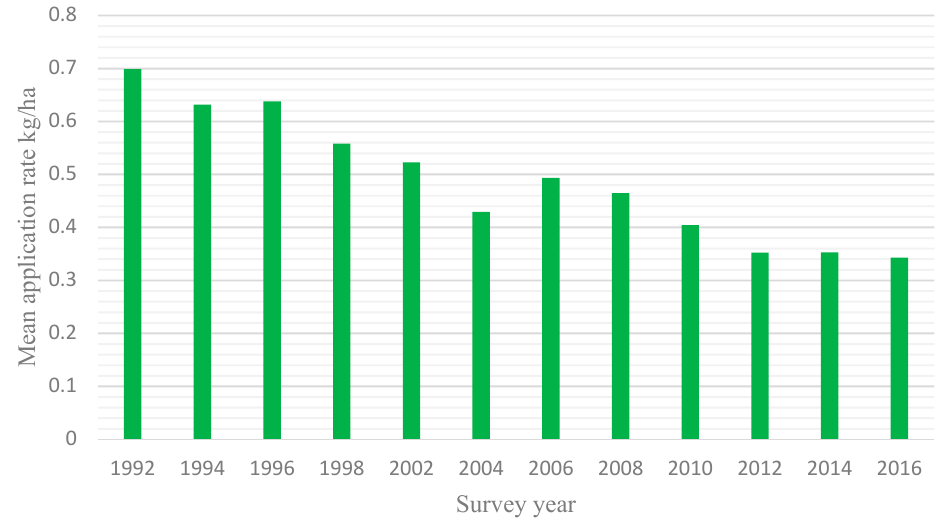
Figure 6. The mean application rate (kg/ha) of the major pesticide groups to arable crops in Northern Ireland 1992–2016.